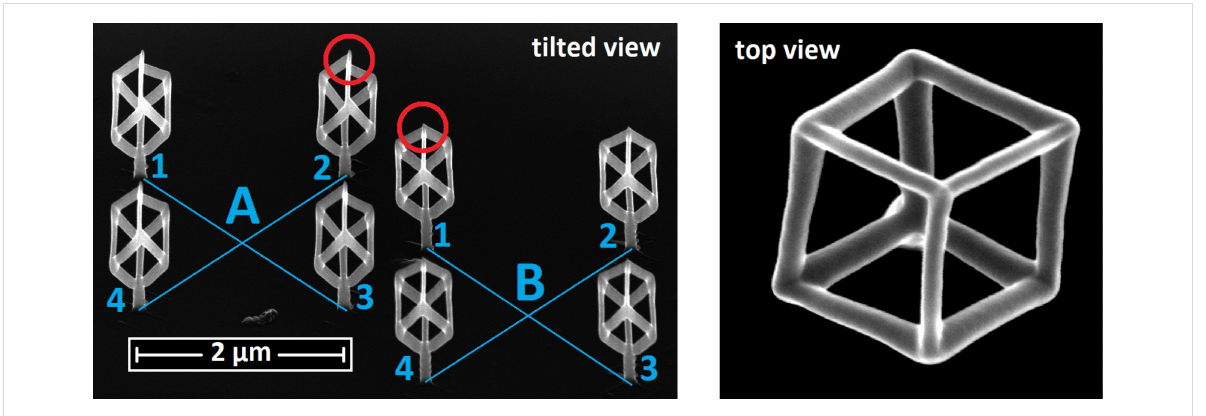
Figure 8: Avoiding of proximity effects: A and B are 2 × 2 arrays of cubes resting on a short pillar. They are deposited next to each other with the exact same parameters and algorithm, except of the order in which the deposition events were written. For A in every frame all three deposition events of one cube are written first before all three deposition events of the next cube follow (A1, A1, A1, A2, A2, A2, …). For B each consecutive deposition event takes place at a different cube (B1, B2, B3, B4, B1, B2, …). Note that in A the growth rate of the edges varies strongly, which is